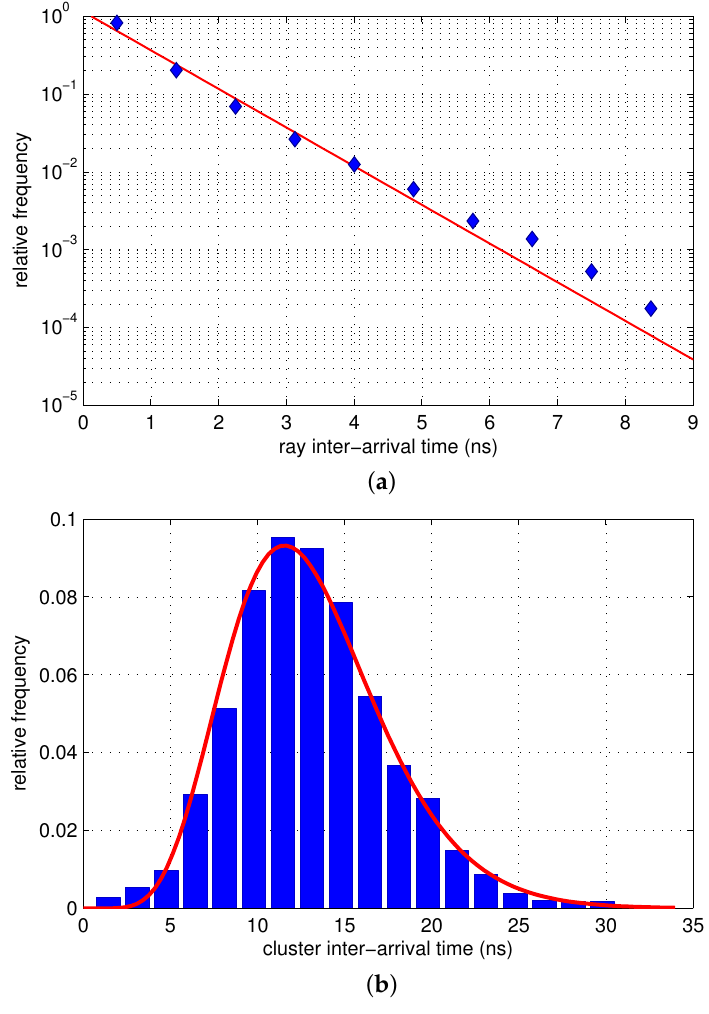
Figure 4. Distributions of the ( a ) ray and ( b ) cluster inter-arrival